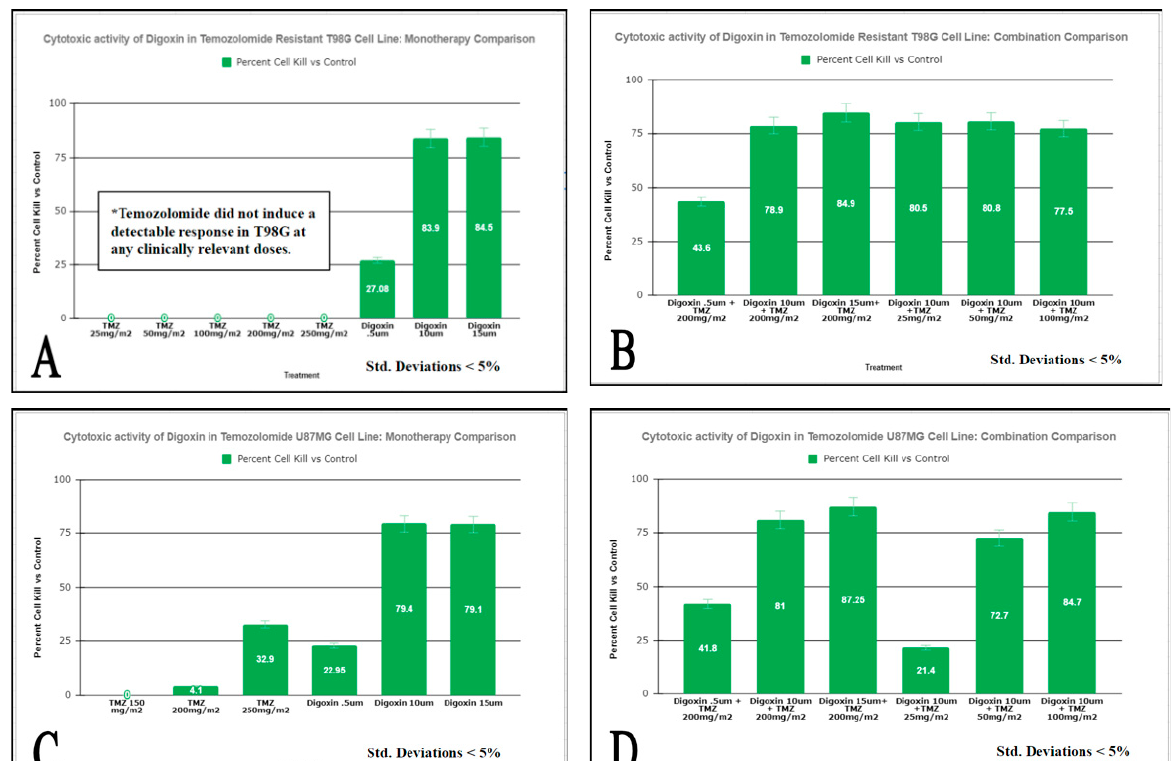
Figure 1. Measurement of cell viability following TMZ and Digoxin Monotherapies and Combination therapies on T98G Cells (panels ( A , B )) and U87MG (panels ( C , D )) assessed by MTT Assay. T98G and U87MG cells were exposed to a one-hour pulse to the combinations of drugs listed above followed by a 24-h incubation period. MTT was added and cell viability was measured as described in “Materials and methods. Results are expressed as % of the control (95% kill ETOH). Values are the average of 8 replicates at p < 0.05.